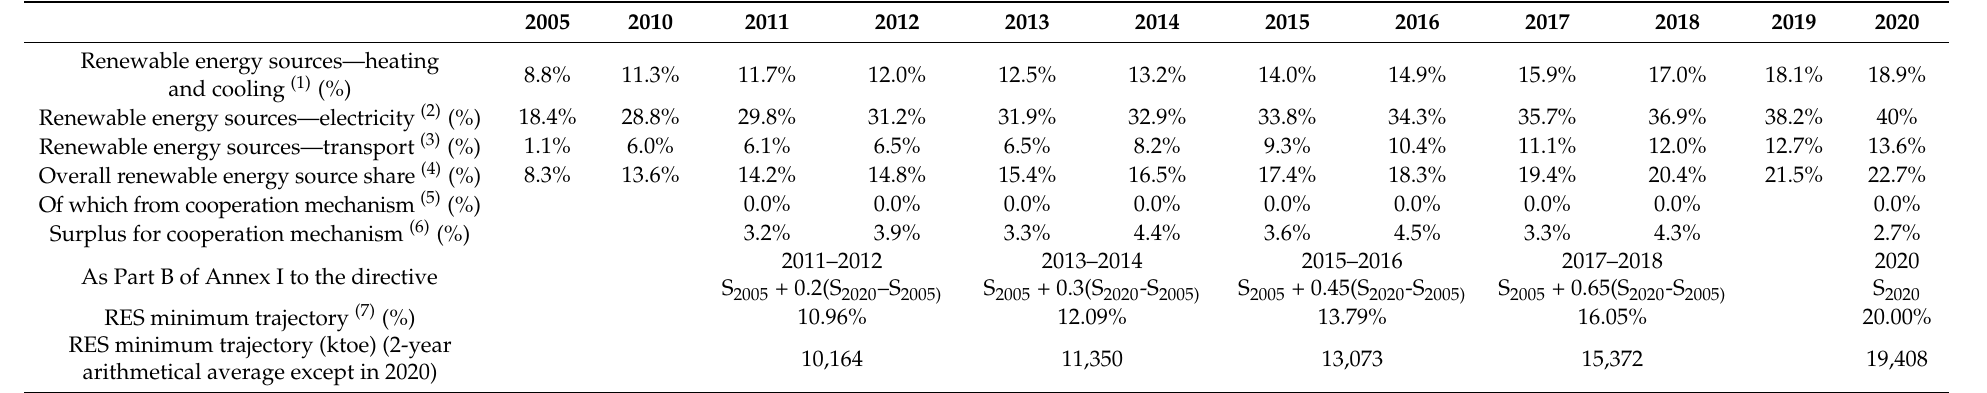
Table 3. Spain’s target and estimated trajectories in heating/cooling, transport, and electricity [25].